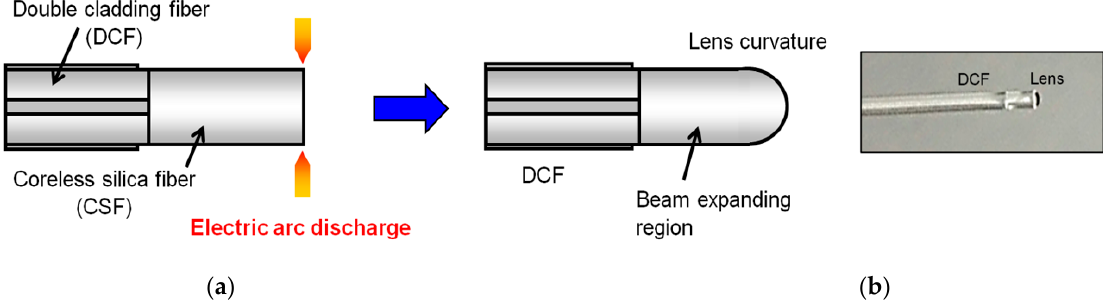
Figure 2. ( a ) Fabrication process of DCF lens and ( b ) photograph of fabricated DCF lens. DCF lens is fabricated by forming the lens curvature at the tip of the coreless silica fiber.